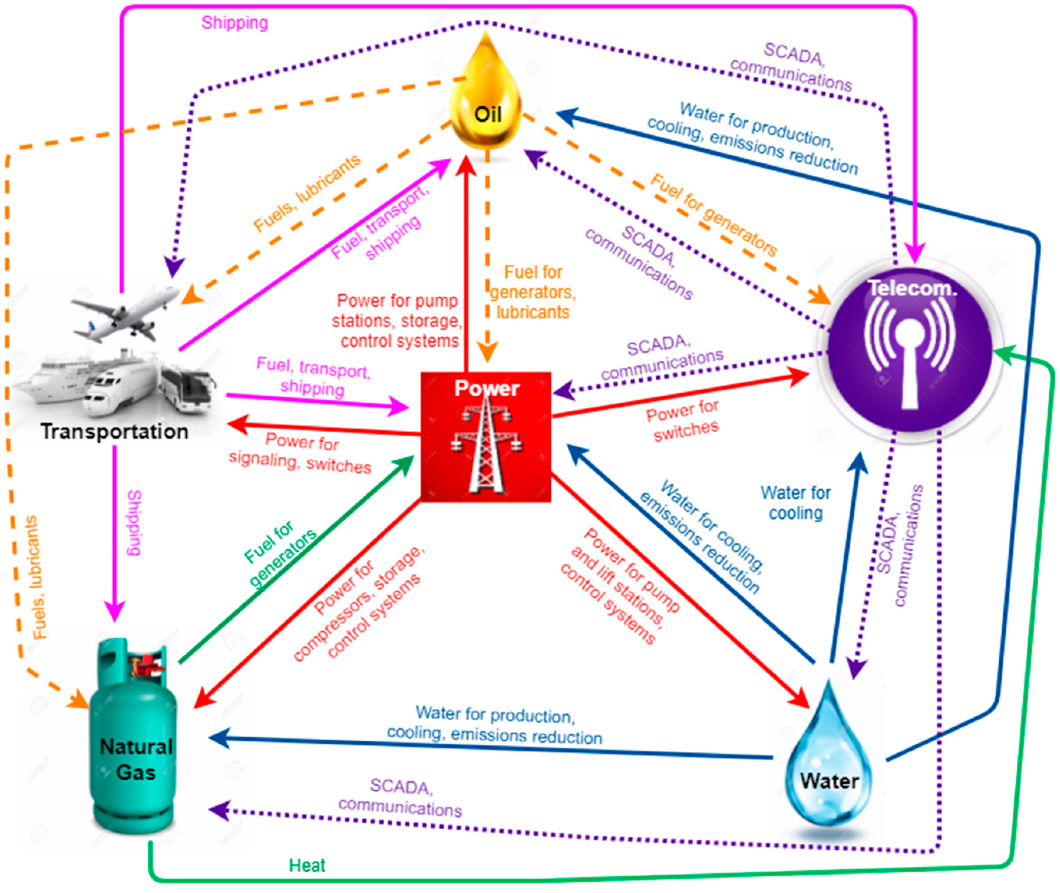
Figure 1. External interdependencies between power systems infrastructure and other critical infrastructure systems (CIS).